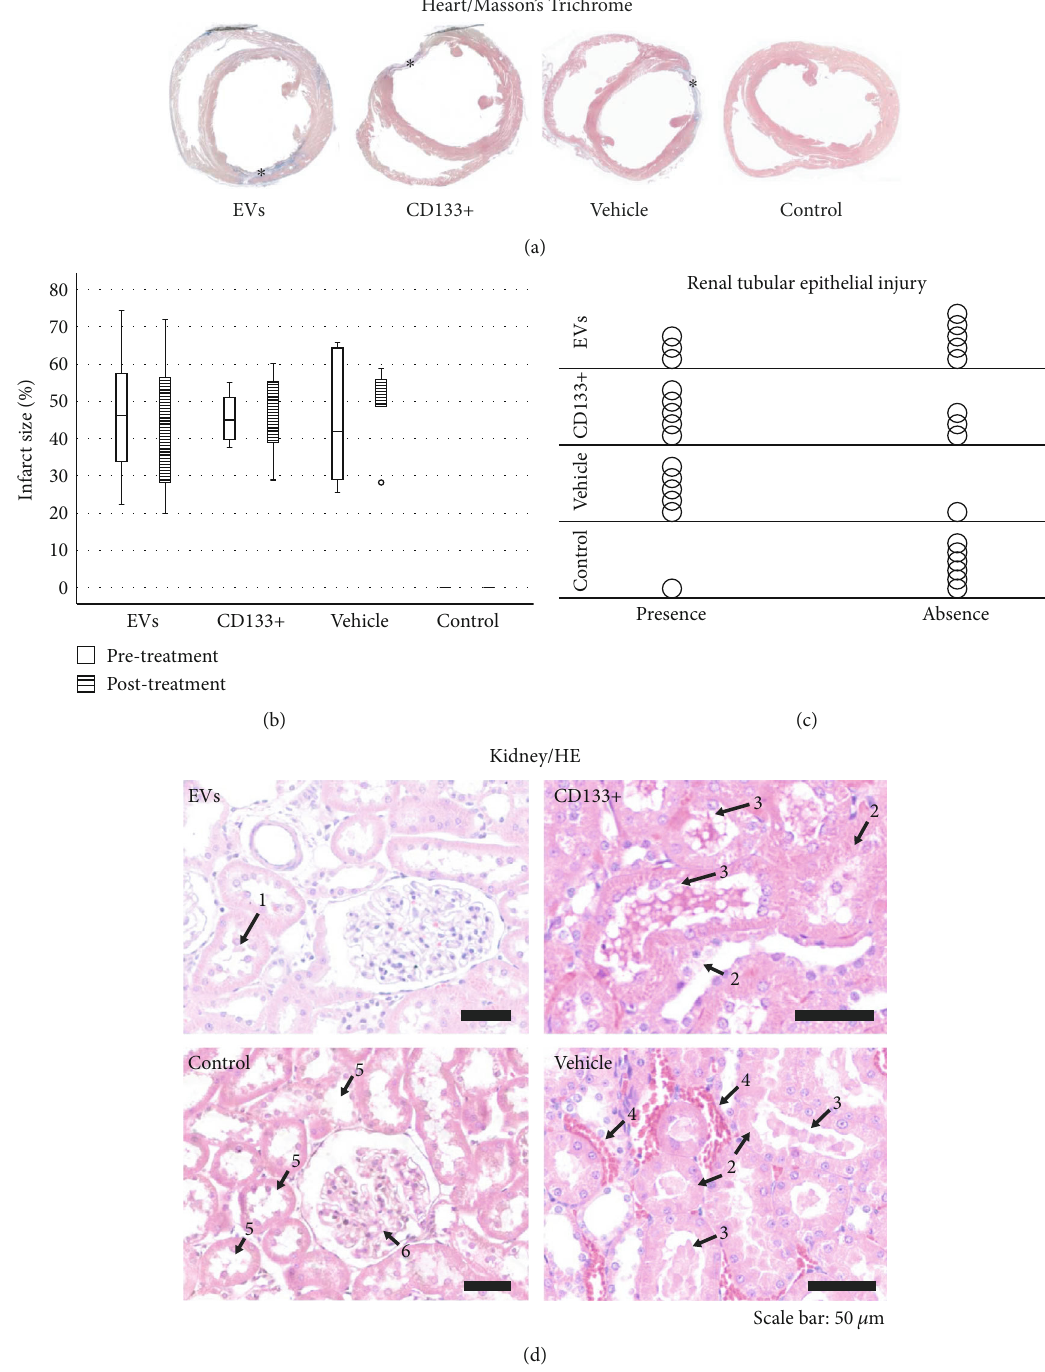
Figure 4: E ff ect of expanded CD133 + cells and expanded CD133 + cell-derived EVs on infarct size and renal injury. (a) Representative Masson ’ s trichrome-stained section of hearts from each of the four groups. Blue staining is showing collagen deposition after myocardial infarction induction. (b) Echocardiographic evaluation of infarct size within each group before and after transplantation. (c) Comparison of the occurrence of renal tubular epithelial lesion between groups. Each circle in the graphic represents an animal. (d) Representative micrographs of renal histology from each of the four groups at day 28 after treatment administration. Arrow number 1 indicates evidence of renal necrotic cells fl aking o ff to the tubular lumen, number 2 shows cell necrosis from the tubular wall, number 3 indicates evidence of renal tubules with Tamm-Horsfall (THP) protein, number 4 indicates vascular congestion, and number 5 indicates evidence of corpuscles while arrow number 6 shows preserved renal tubules in control healthy group. ° : outlier value; EVs: transplanted with expanded CD133 + cell-derived EVs; CD133 + : transplanted with expanded CD133 + cells; vehicle: treated with PBS; control: healthy animals ( n = 6 to 8 per